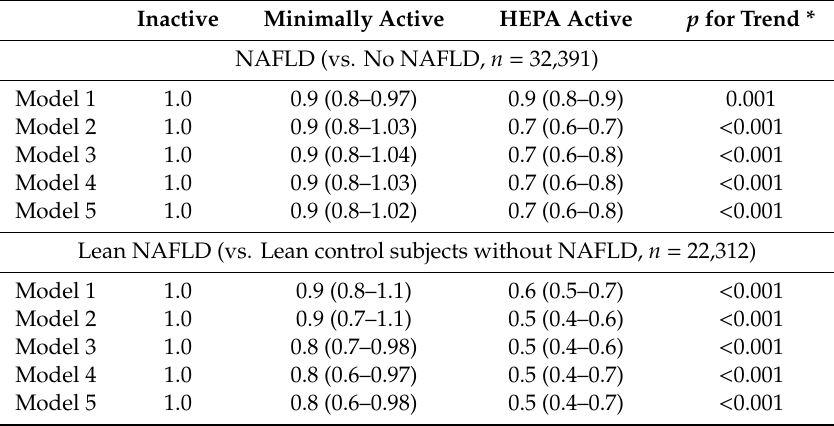
Table 3. Adjusted OR for the independent association of physical activity with